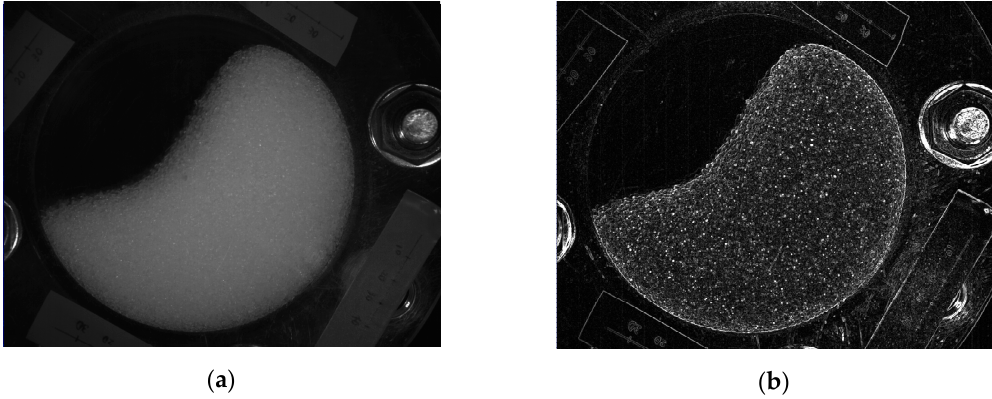
Figure 5. Picture of the Kirsch filter image: ( a ) a photo of the experiment taken with a high-speed camera; ( b ) applying the Kirsch filter.